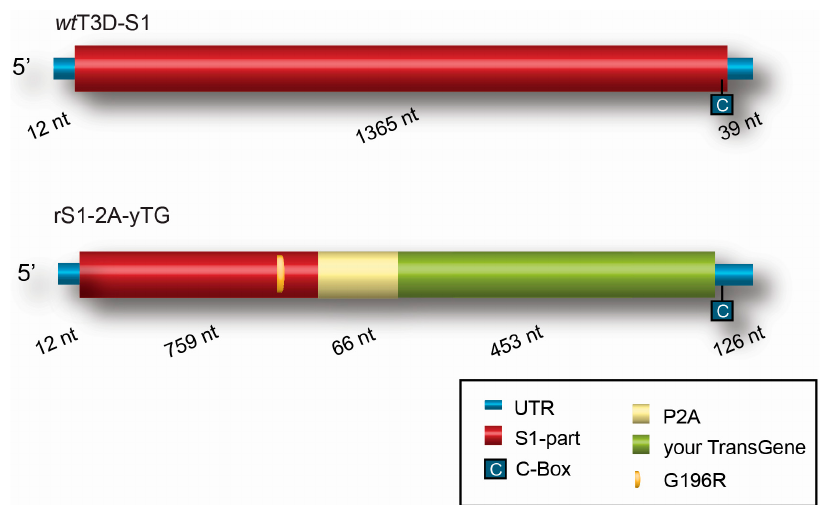
Figure 2. Scheme of recombinant S1 gene segment compared to wild-type T3DS1. rS1-2A-yTG is the recombinant S1 segment containing your transgene (yTG) downstream of a porcine teschovirus-1 element (P2A) to separate the encoded protein from the σ 1 part. Entry of the recombinant reovirus by sialic acids is provided by a mutation in the S1-part that results in a G to R amino acid change at position 196 (G196R) in the truncated σ 1 protein. In the 3’Untranslated region (UTR) of the recombinant gene the C-box is important for incorporation of the segment in the viral particles [46]. To not exceed the wild-type size of S1, the inserted transgene might be ~453 nt long. The size of each element is depicted in nucleotides (nt) below each segment.